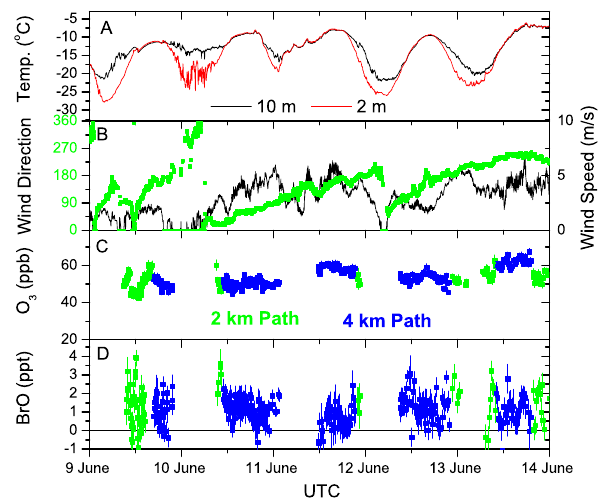
Fig. 5. Period of local airmasses during the beginning of the 2008 GSHOx experiment. Strong temperature gradients between 2m and 10m altitude (A) and low wind speeds (B) were observed at night during this period. Ozone mixing ratios (C) showed little variability, while BrO (D) varied between 0–5ppt. The gaps in LP-DOAS data at night are due to the reduced visibility in the presence of ground